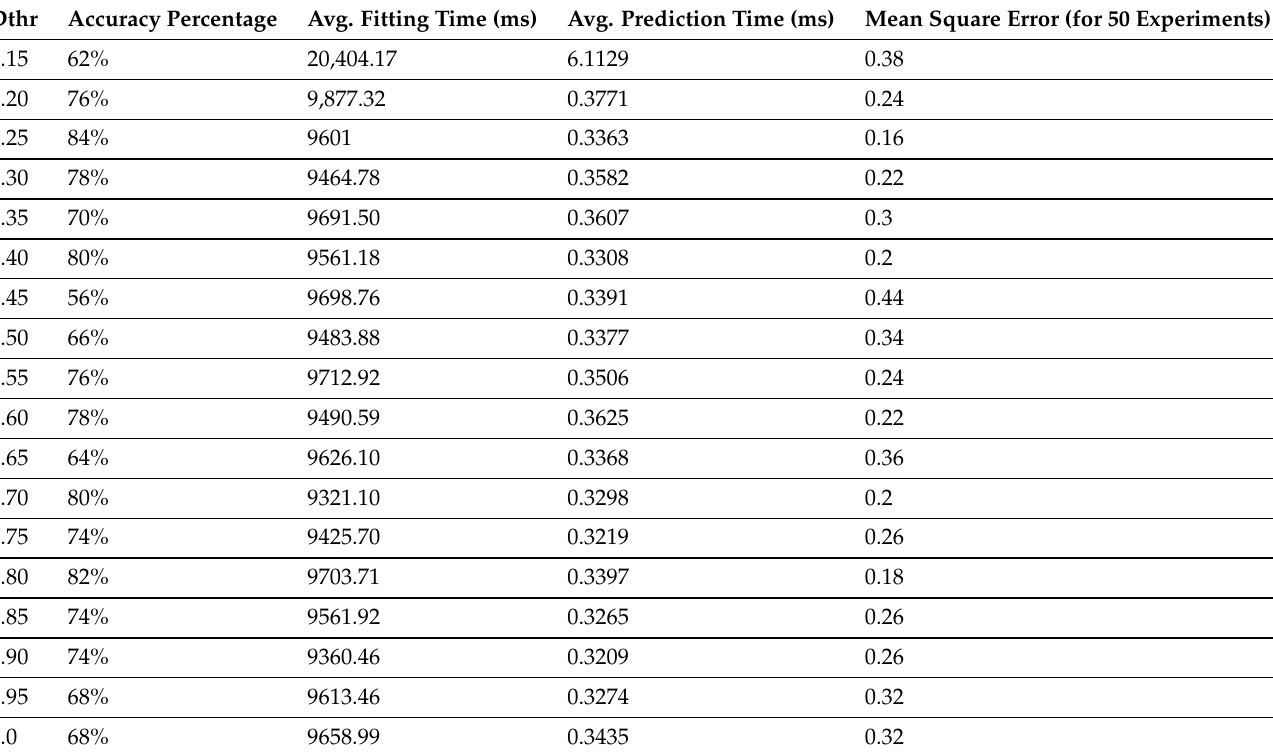
Table 8. TWNFI evaluation depending on the ECM radius parameter, on a dataset of 250